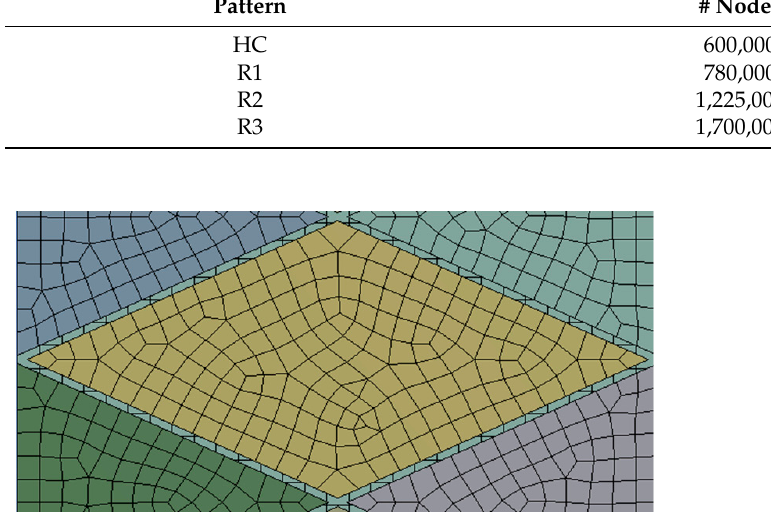
Table 5. Mesh details for the Honeycomb cell (HC) and for the three rhomboidal cells (R1, R2, R3). Pattern